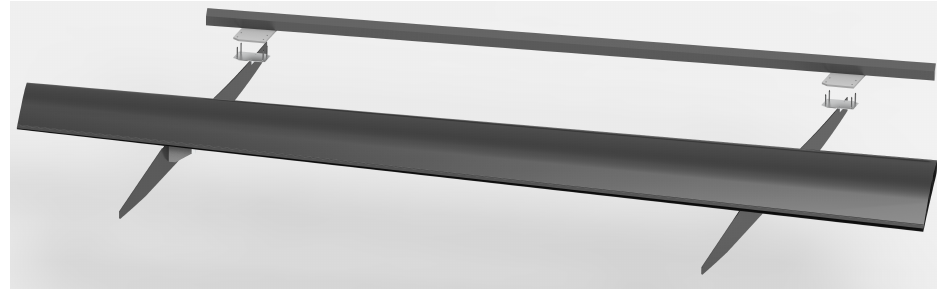
Figure 5. Lightweight demonstrator of fully equipped flap with spar